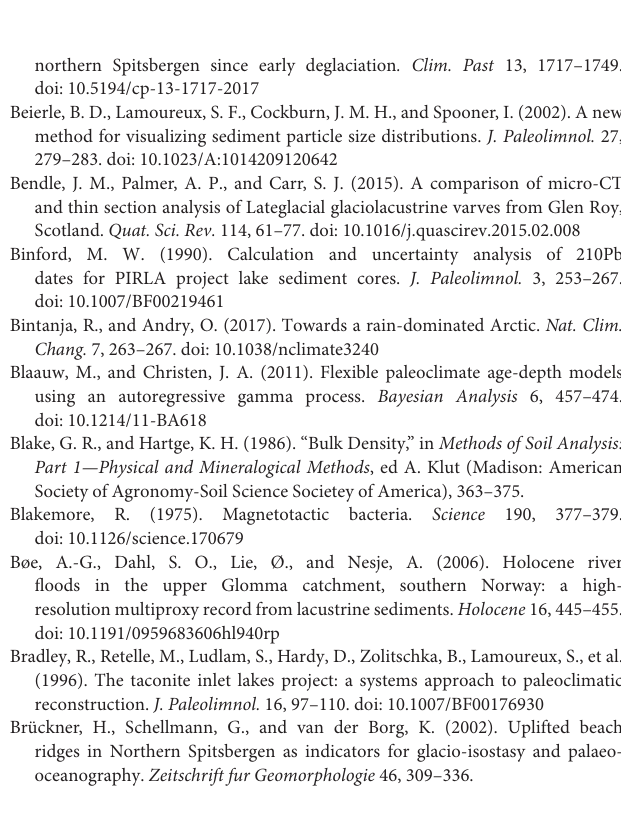
Figure S1 | Selected interval from VAP114 (69–74cm) showing a 3D image of the X-ray CT scan. The grayscale color corresponds to the relative density of the sediments, where the brighter color represents the densest material. The red arrows show the position of grain-size measurements using the Mastersizer 3000 from Malvern obtained from a distinct layer in VAP114. Table S1 | The results from the 210 Pb-dating of the VAD114 done at the Laboratory for Isotope Dating and Environmental Research, Institute of Geological Sciences at the Polish Academy of